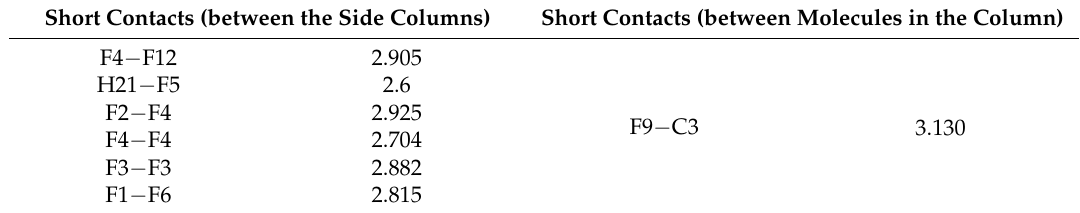
Table 2. Selected intermolecular short contacts (Å) of the molecule 4b .